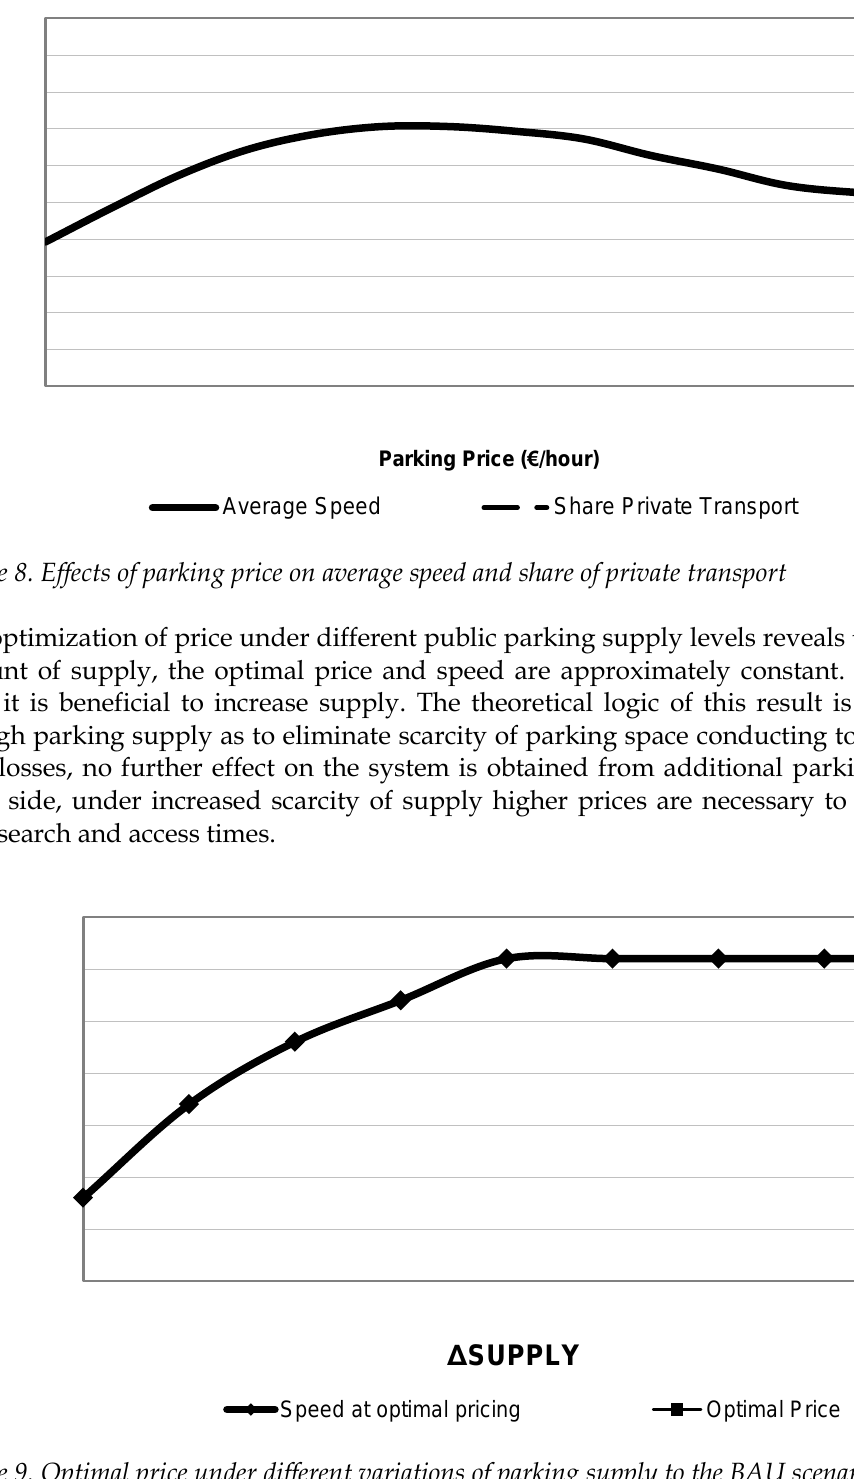
Figure 9. Optimal price under different variations of parking supply to the BAU